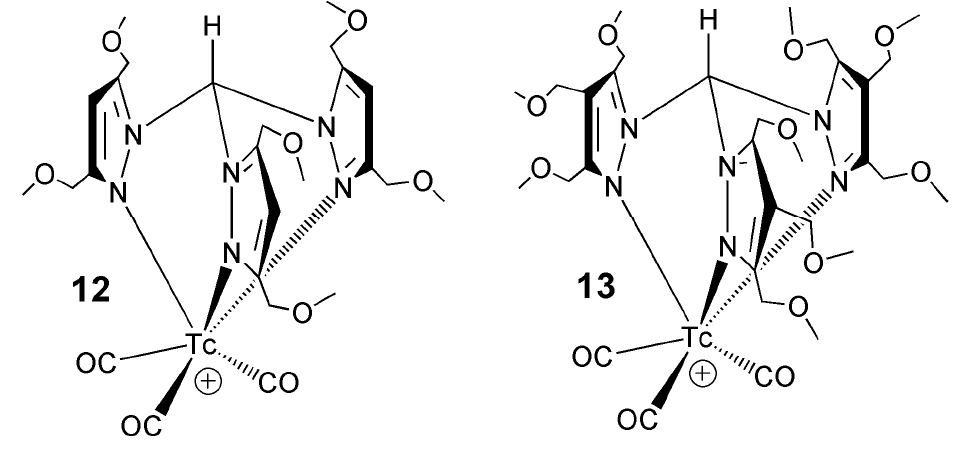
Figure 5. Drawings of the chemical structure of the two novel myocardial 99m Tc-tracers, [Tc(CO) 3 HC { (CH 2 OMe) 2 pz } 3 ] and [Tc(CO) 3 HC { (CH 2 OMe) 3 pz } 3 ] based on scorpionate